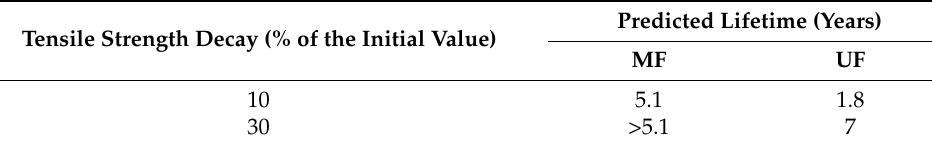
Table 3. Membrane ageing predicted by the data obtained from cleaning with NaOH solution after filtration with TA solution using the exponential models presented in Figure 6. Tensile Strength Decay (% of the Initial